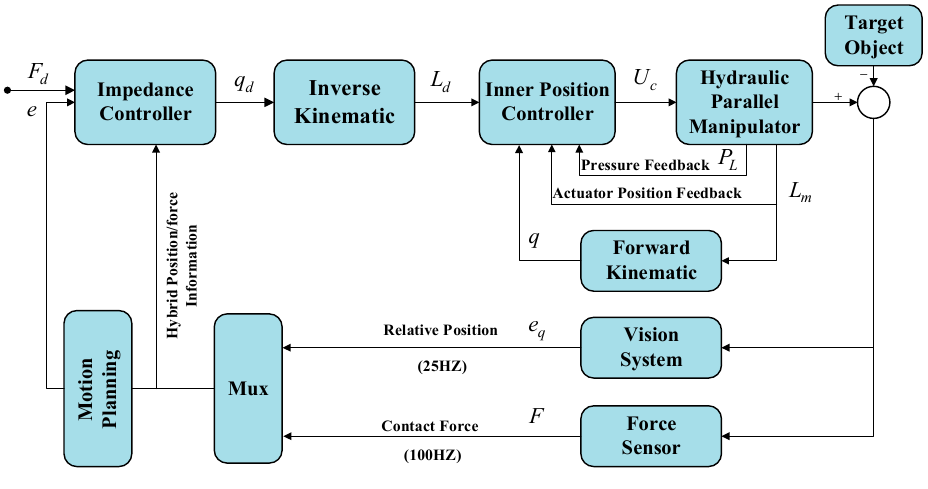
Figure 17. Overall control scheme.